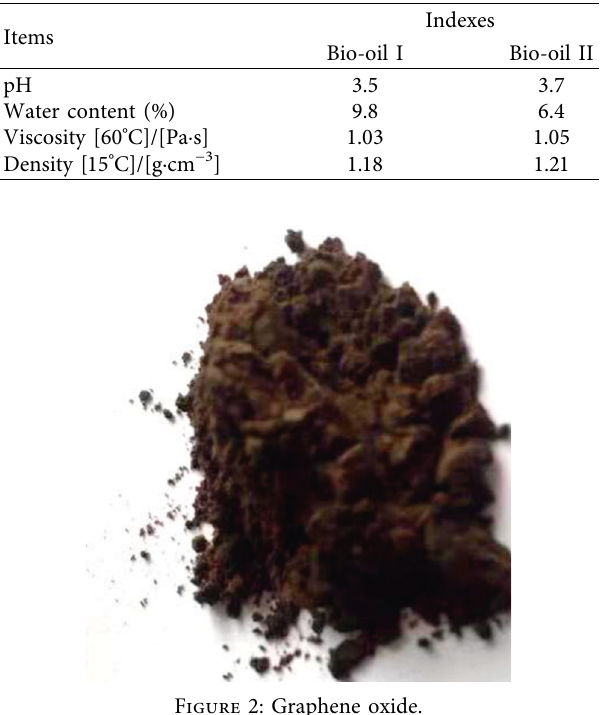
Table 2: Performance indexes of bio-oil.